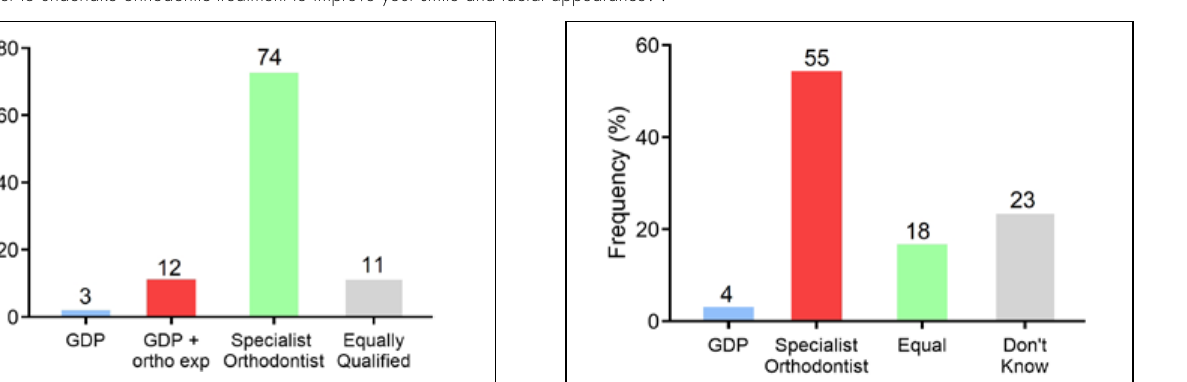
Figure 8. Frequency histogram for responses to Question 3: ‘What is the most important factor in choosing a practitioner to undertake orthodontic treatment to improve your smile and facial appearance?’.